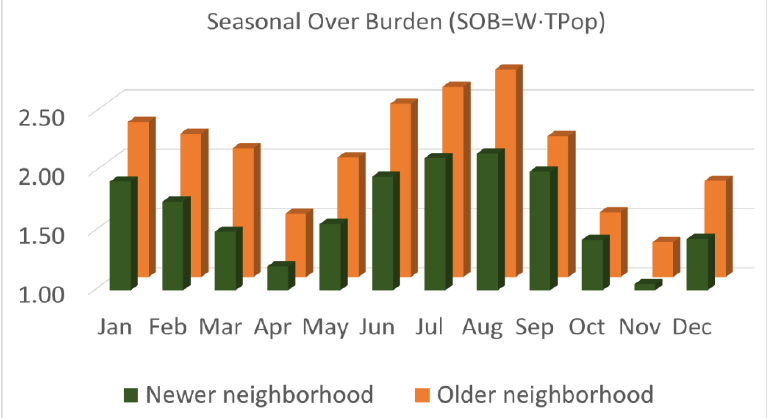
Figure 4. Seasonal overburden (SOB) calculated for two neighborhoods in Mitzpe Ramon. The seasonal variations in weather and tourism in the two neighborhoods impacts emergency response efforts and should be addressed in emergency plans.